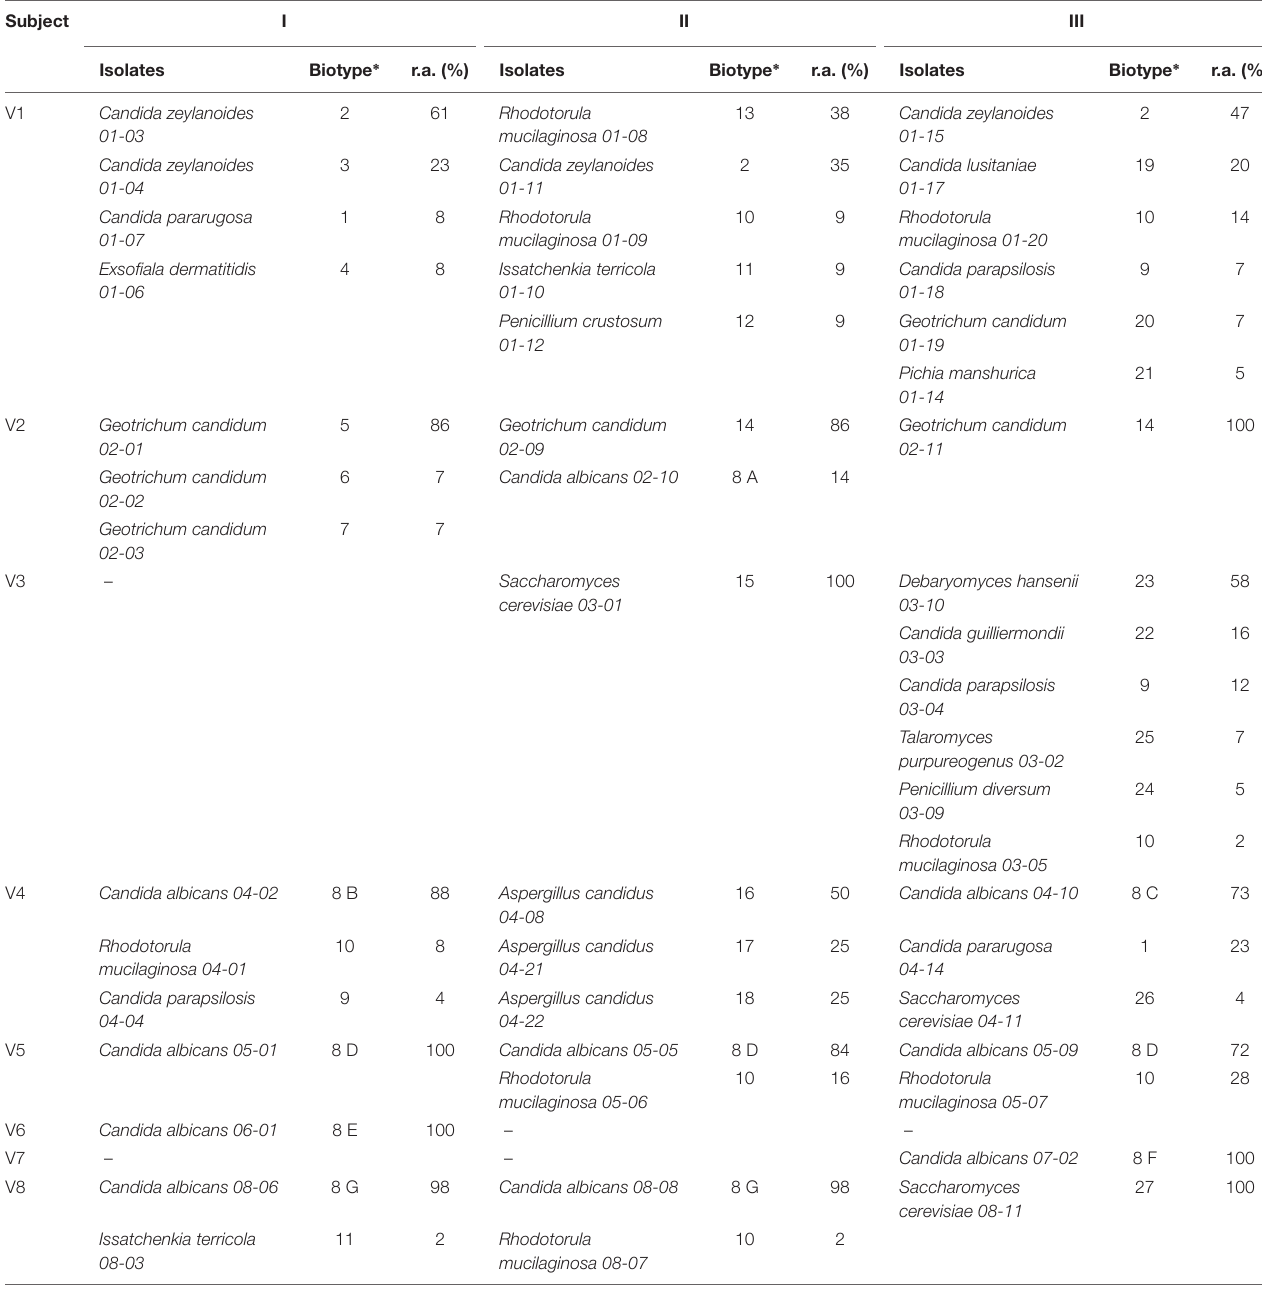
TABLE 2 | RAPD-PCR, SSCP, and MLP analysis of fungal